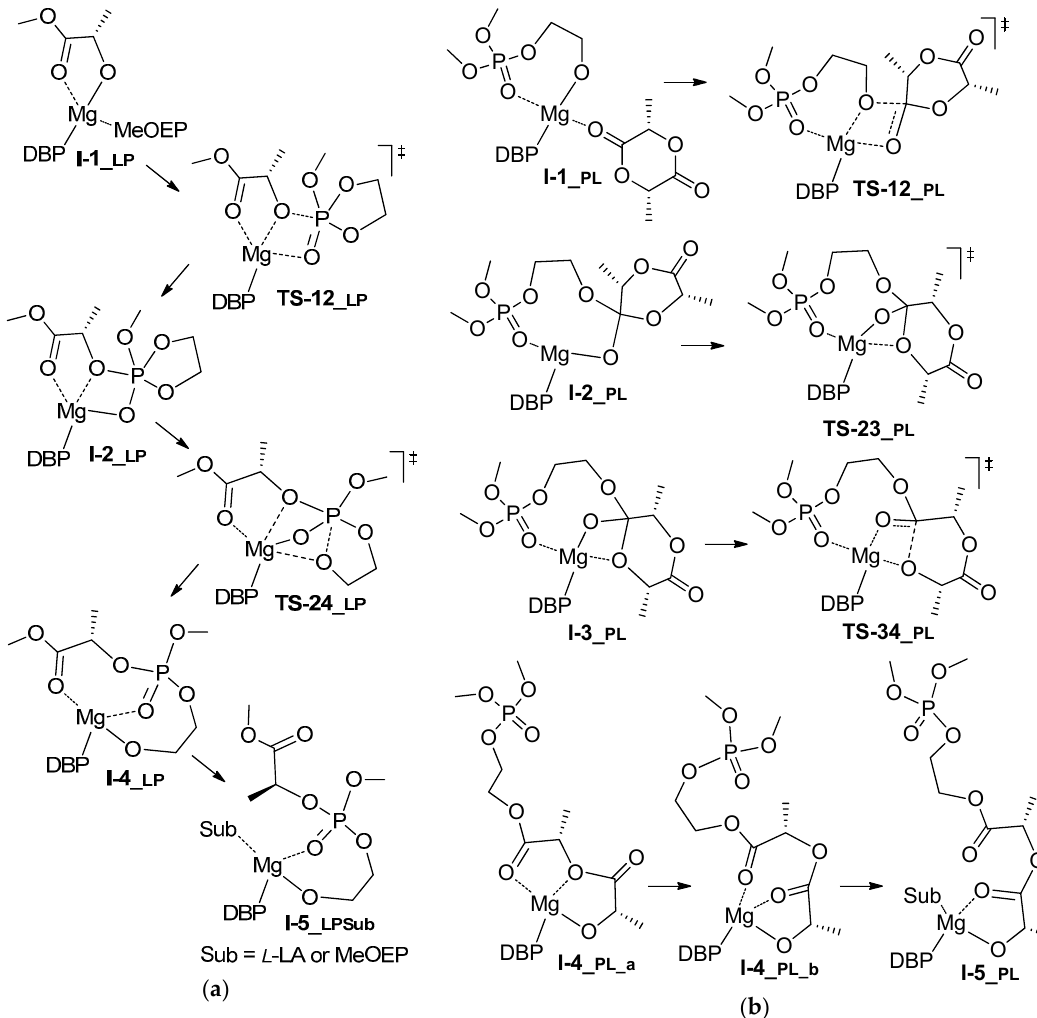
Scheme 6. Mononuclear reaction mechanisms of L -LA/MeOEP copolymerization: ( a ) LP sequence and ( b ) PL